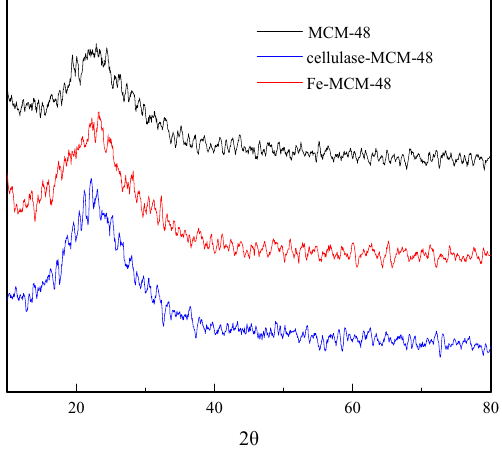
Figure 6. XRD micrographs of catalysts.